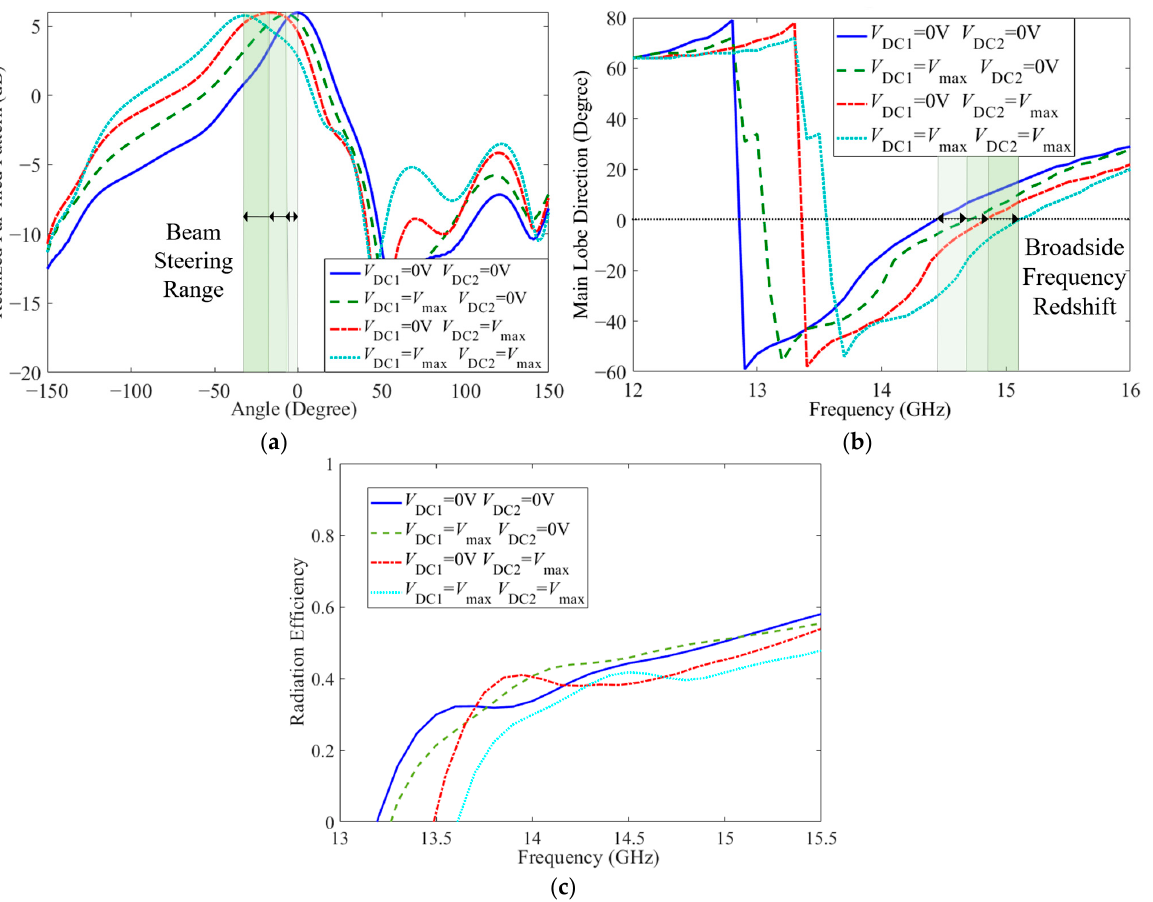
Figure 7. Radiation of the CRLH metamaterial antenna: ( a ) the realized far-field pattern at 14.4 GHz under dual-tuned mode of LC, ( b ) curve of the main lobe direction varies with frequency under dual-tuned mode of LC and ( c ) radiation efficiency of the antenna. Table 2. Comparison for the zero frequency between the unit cell and the